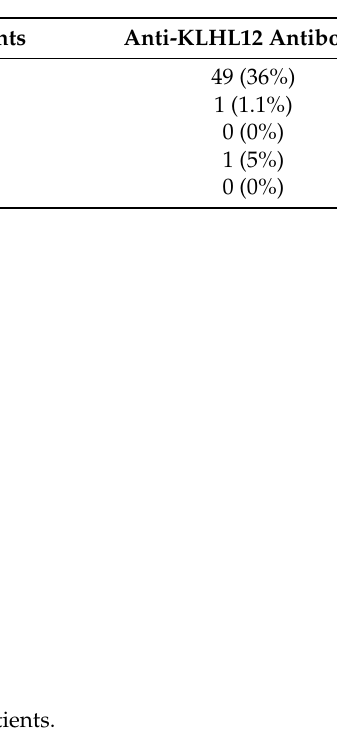
Table 3. Occurrence of anti-KLHL12 antibodies in patients with PBC and control groups.